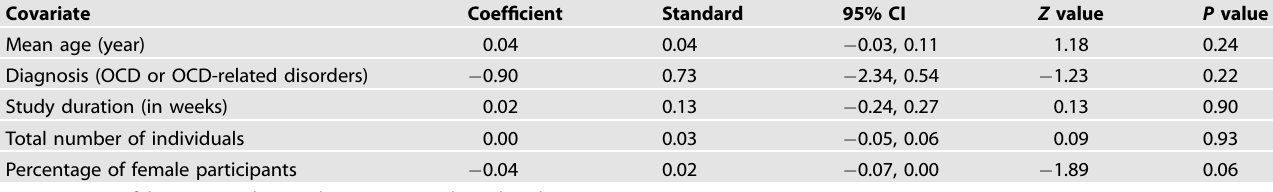
Table 3. Meta-regression analysis for overall symptoms: N-acetylcysteine versus placebo.